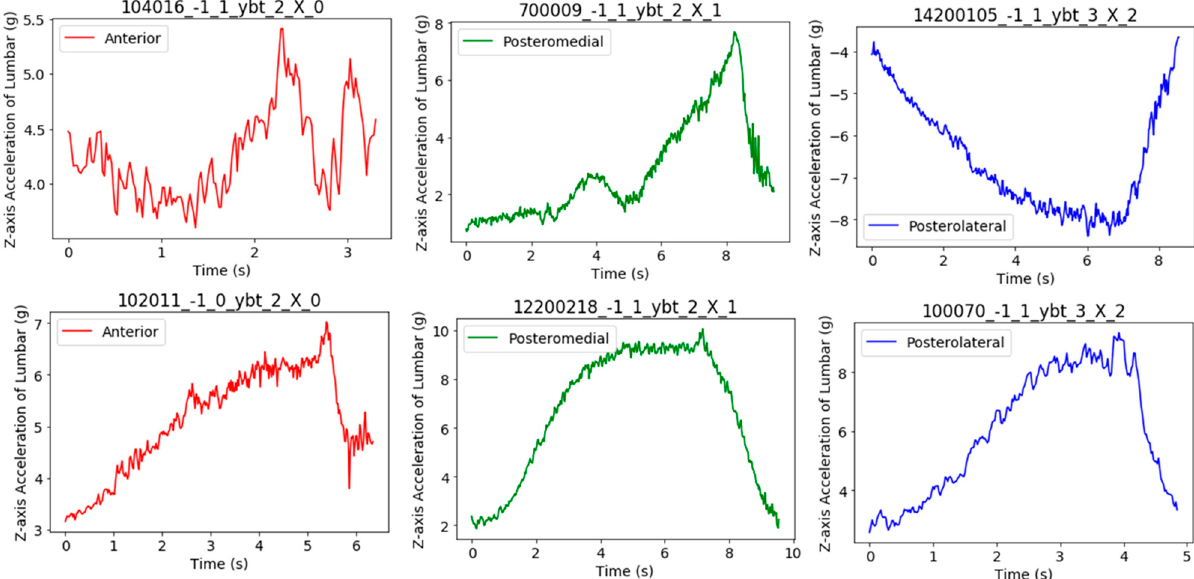
Figure 13. YBT excursions from subjects with the lowest correlation ( top ) and subjects with the highest correlation ( bottom ).